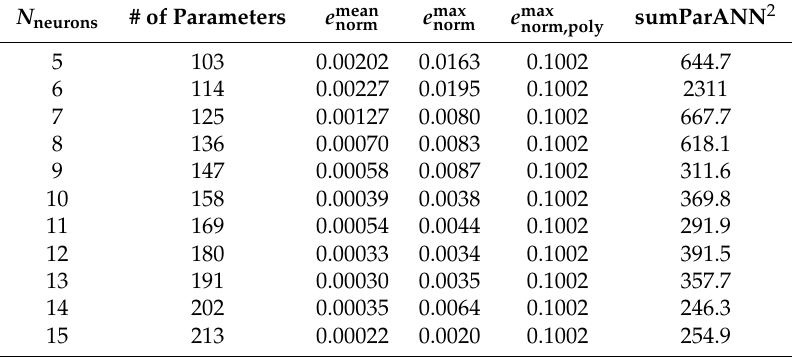
Table 3. Performance metrics for the surrogate model. The sum of squared parameter values of the ANN is denoted by sumParANN 2